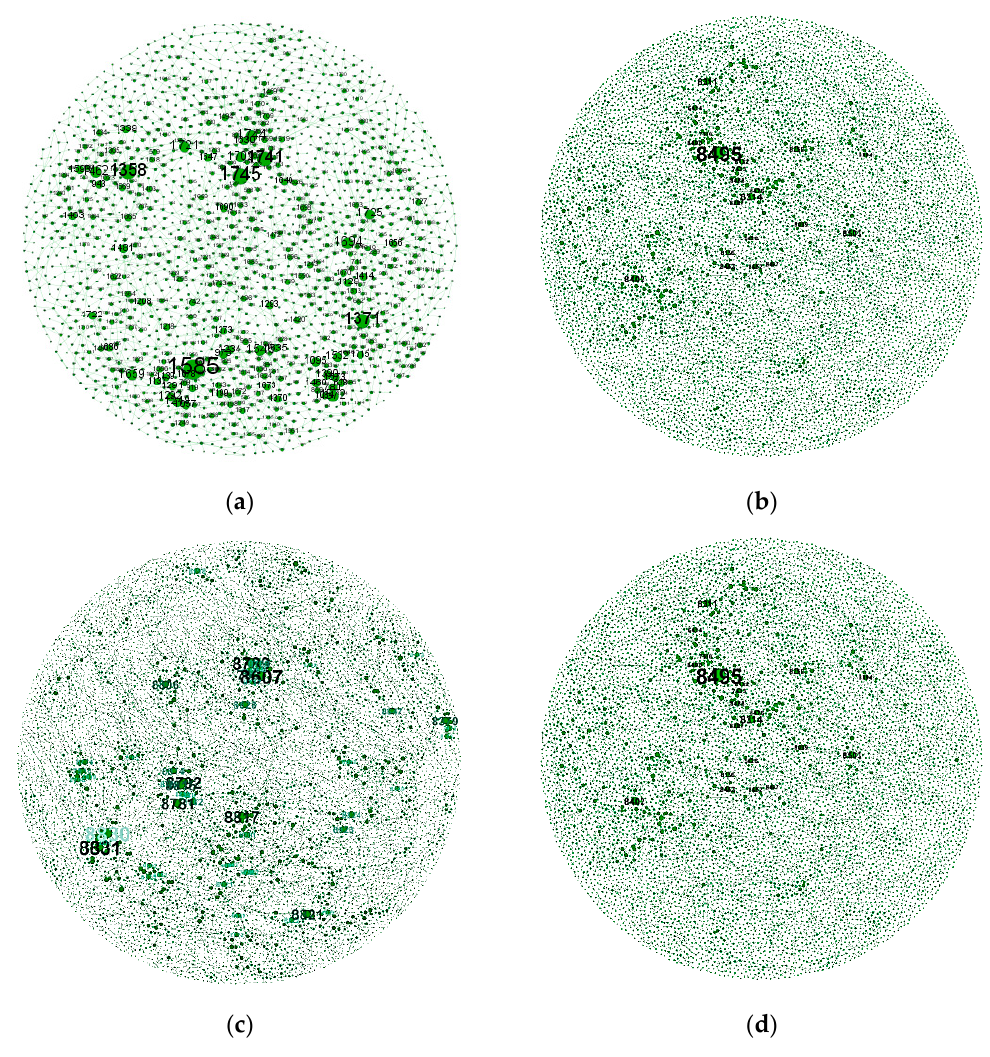
Figure 9. Centrality sorting of sandstone pore nodes: ( a ) 14.1%; ( b ) 16.9%; ( c ) 17.1%; ( d ) 24.6%.